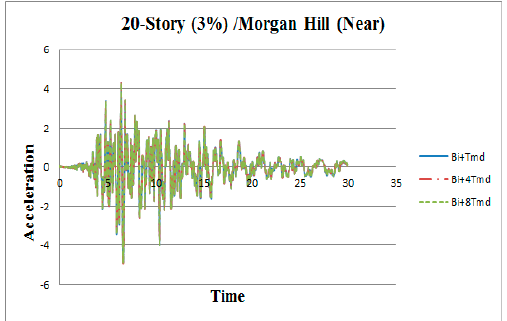
Figure A11. Acceleration time histories for top story of 20-story building under the Loma Prieta (near-fault) earthquake.